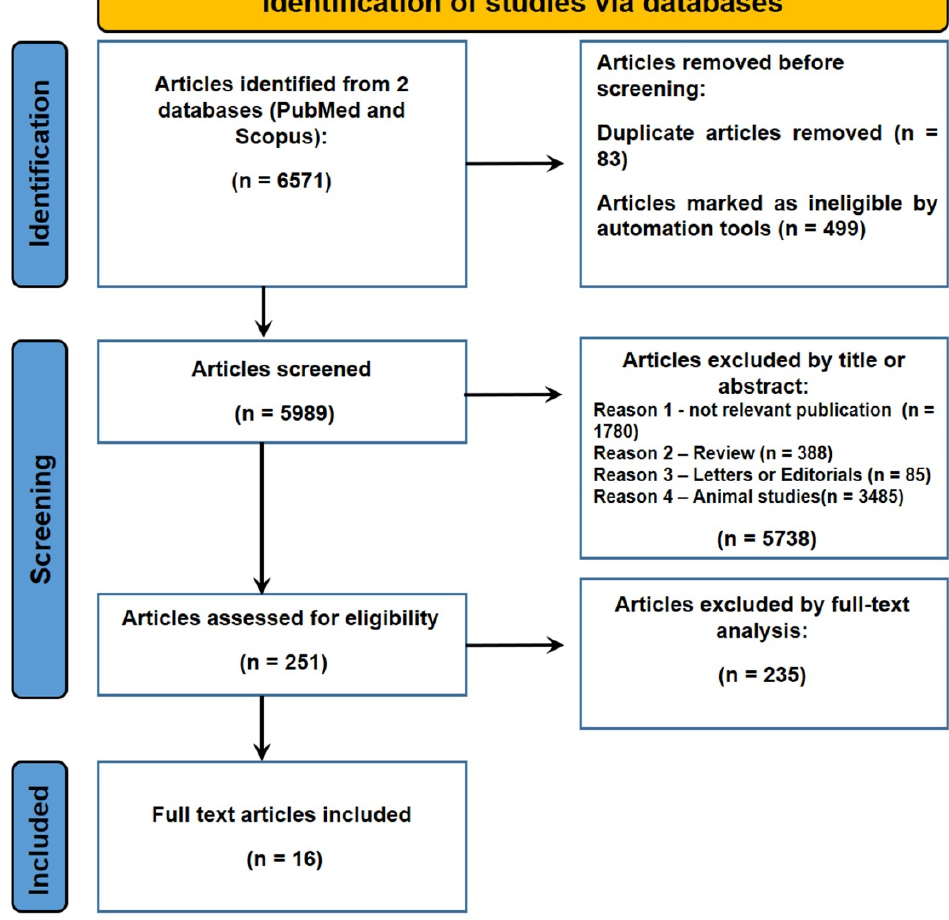
Figure 1. Flow diagram illustrating the studies included and excluded in this systematic literature